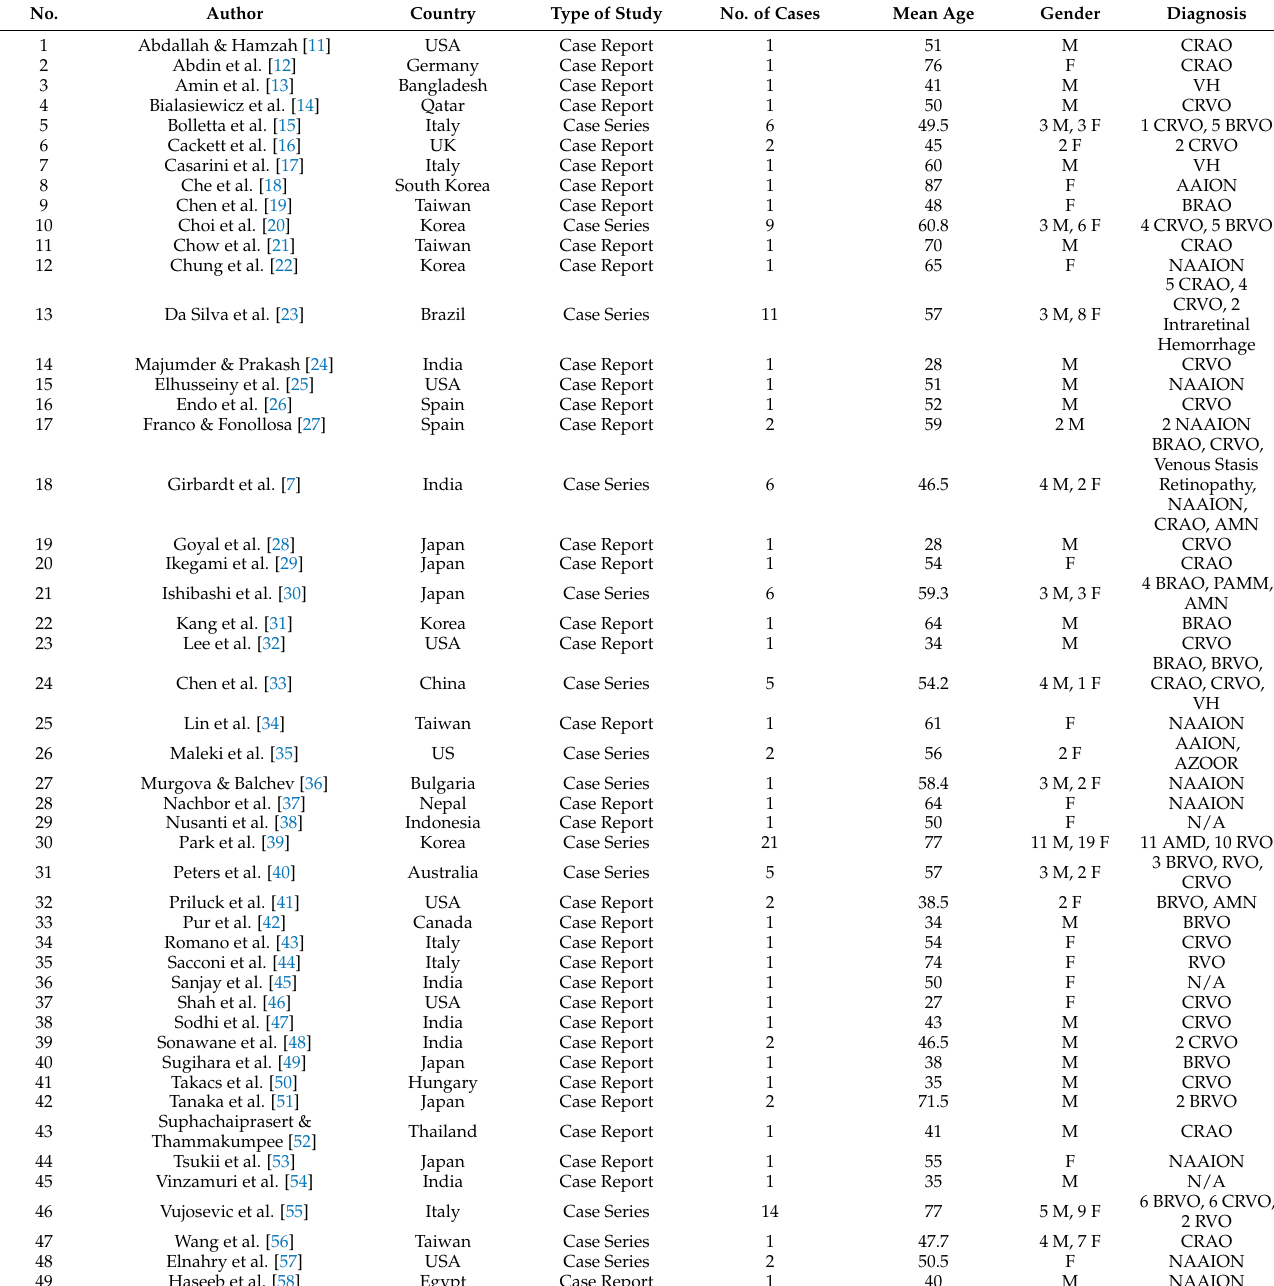
Table 1. Summary of papers reviewed in this systematic